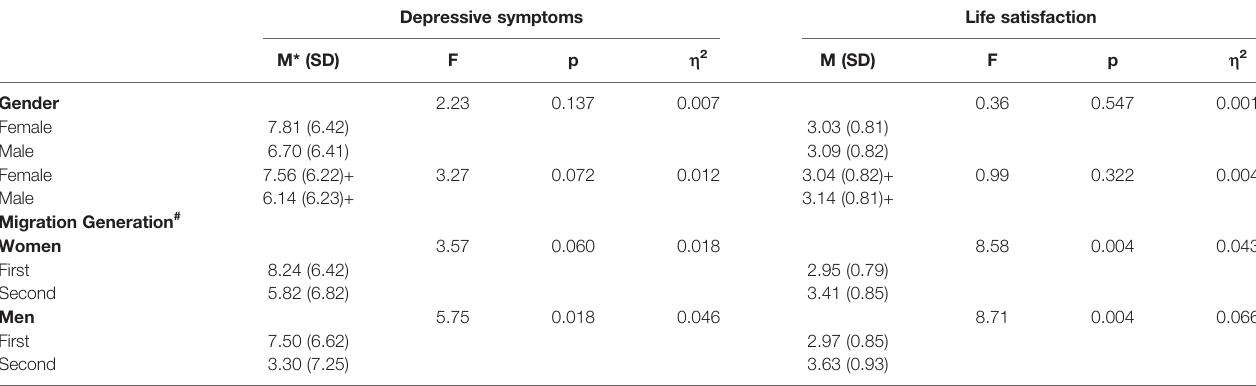
TABLE 3 | Differences in degrees of depressive symptoms and life satisfaction among persons of Turkish origin by gender and migration generation (gender-strati fi ed). Depressive symptoms